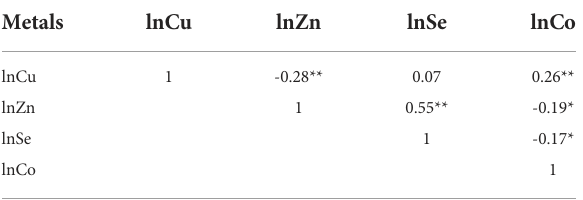
*indicates p value < 0.05; ** indicates p value < 0.001 Table 4.